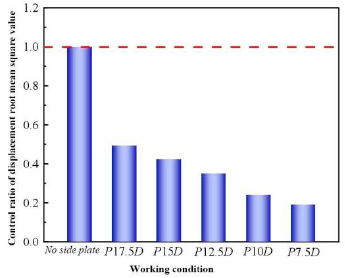
Figure 22. Crosswind displacement response at monitoring point 1 under a windspeed of 6 m/s and different pitch conditions.